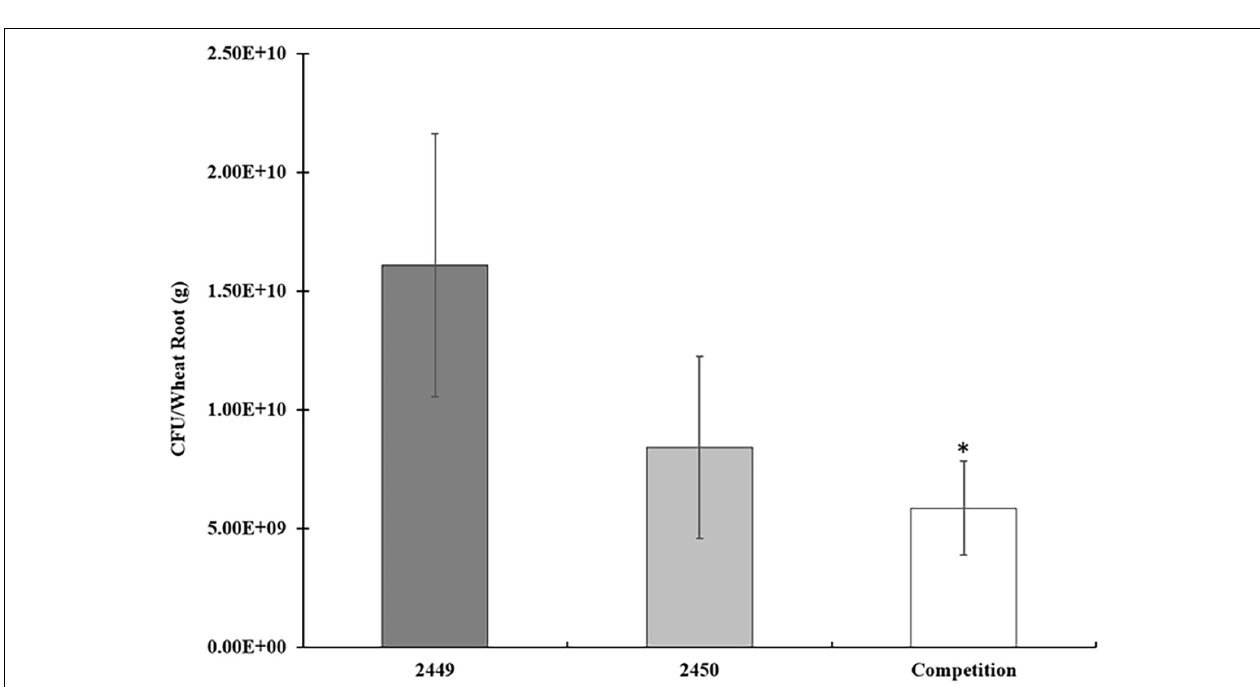
FIGURE 5 | Competition assays in wheat roots: A. baldaniorum 2449 WT strain, A. baldaniorum 2450 mutant strain, and competition assay seedling inoculated with 1.1 with both strains, as described in “Materials and Methods” section. Bar plots representing the mean and standard error of colony-forming units recovered per gram of wheat root from colonization assays. The data was obtained from three independent experiments. The mean of WT and the competition assay was compared with a Student’s t -test and was significantly different with a P- value = 0.0142 indicated with one asterisk.